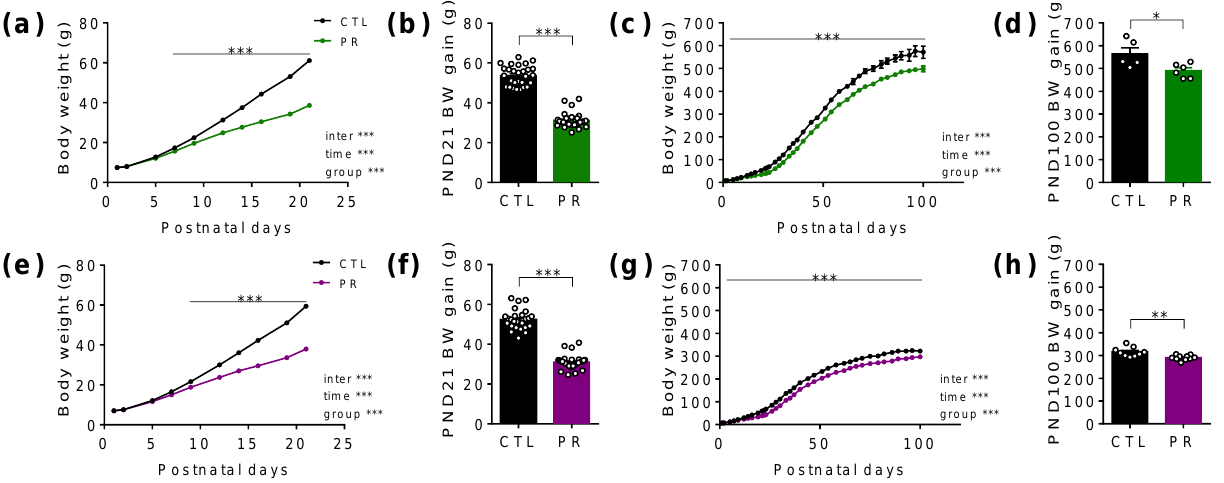
Figure 4. Postnatal growth of male and female offspring. Body weight (BW; a , c , e , g ) and BW gain at postnatal day (PND) 21 ( b , f ) and PND100 ( d , h ) have been followed in male ( a – d ) and female ( e – h ) offspring from the birth. Black line, CTL; coloured line, PR. Green, male; purple, female. CTL, control. PR, protein restriction. Data are mean ± SEM or individual values ( n = 5–31). * p < 0.05, ** p < 0.01, *** p < 0.001 vs. CTL, 2-way ANOVA with Sidak post-test, unpaired t -test.